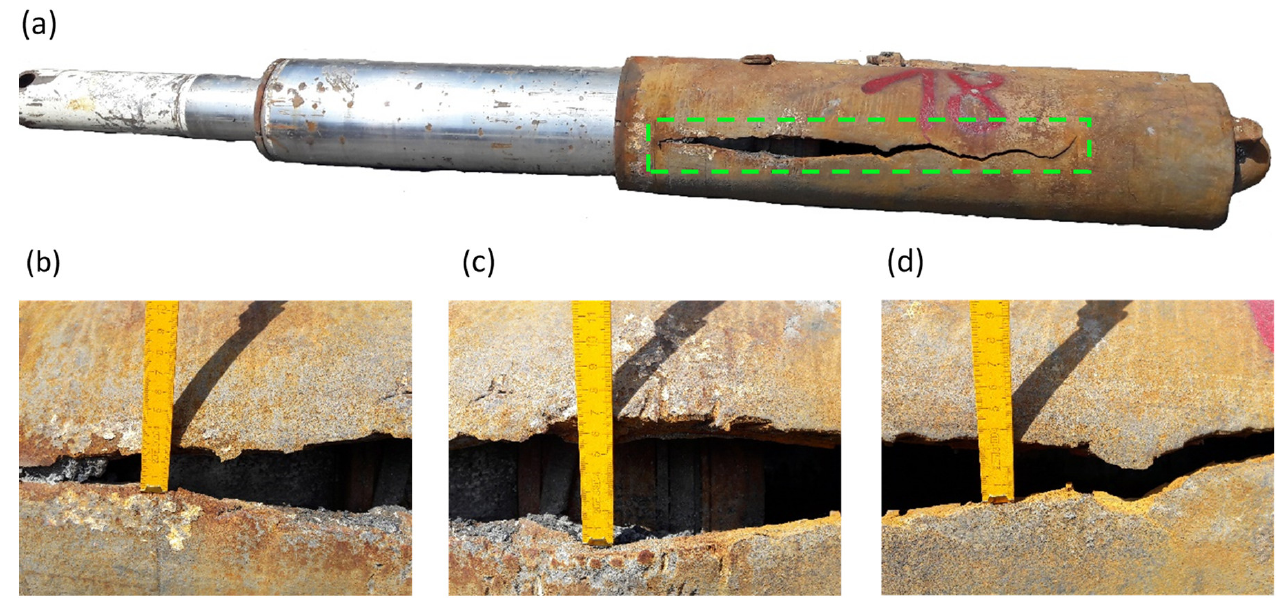
Figure 2. Damaged cylinder of the first stage of a double-telescopic hydraulic leg, where: ( a ) crack area ( b ) area of minimal cracking in the initial phase, ( c ) maximum crack area, ( d ) final rupture area.